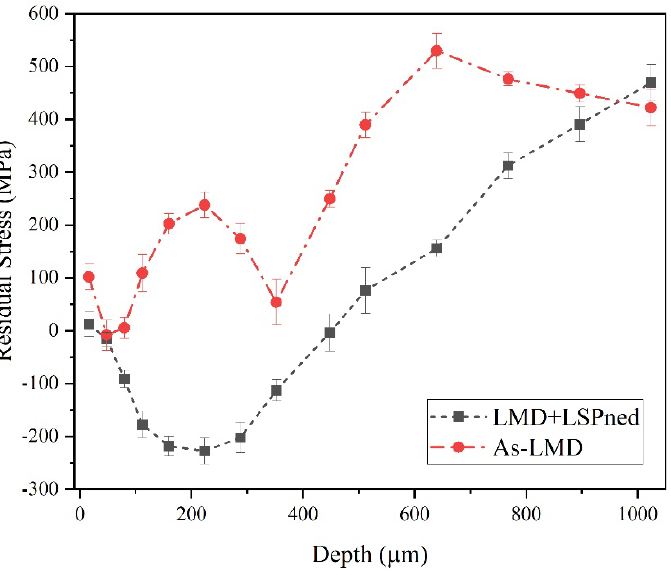
Figure 5. The in − depth residual stress distribution of as-LMD and LAM+LSPned samples.